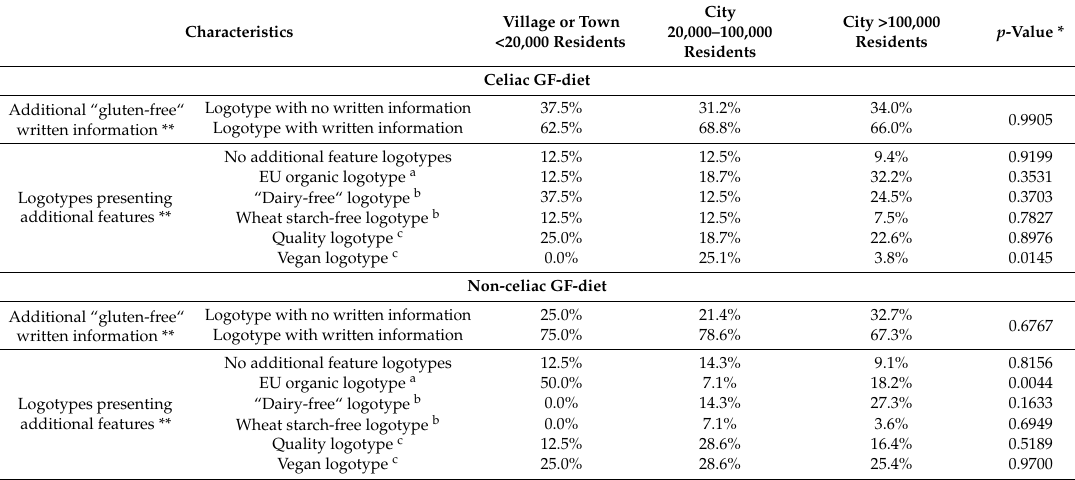
Table 8. The comparison of the front-of-package “gluten-free” (GF) product labeled attributes influencing the choice of GF bread in subgroups of celiac GF-diet and non-celiac GF-diet diet participants stratified by place of